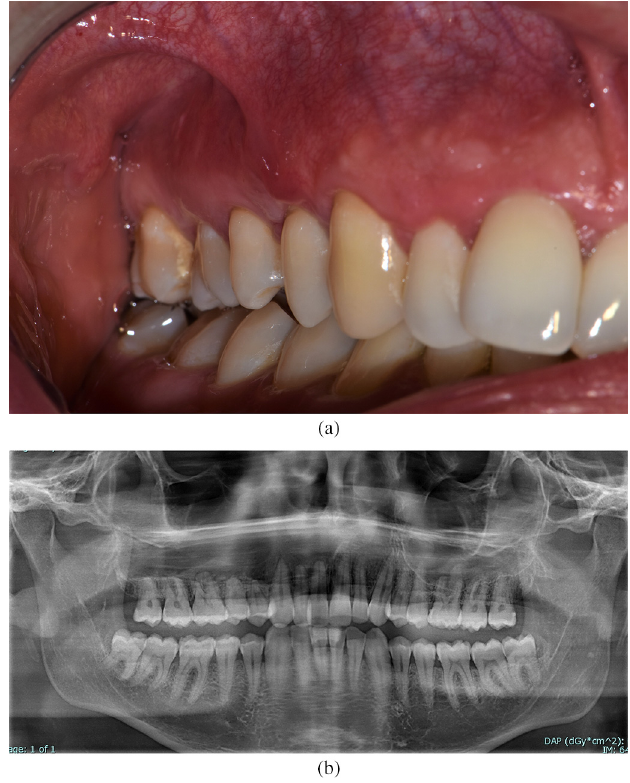
Fig. 3. Six-months follow-up: intra-oral complete clinical healing (a); involved teeth maintain vitality despite root resorptions detectable on orthopantomography